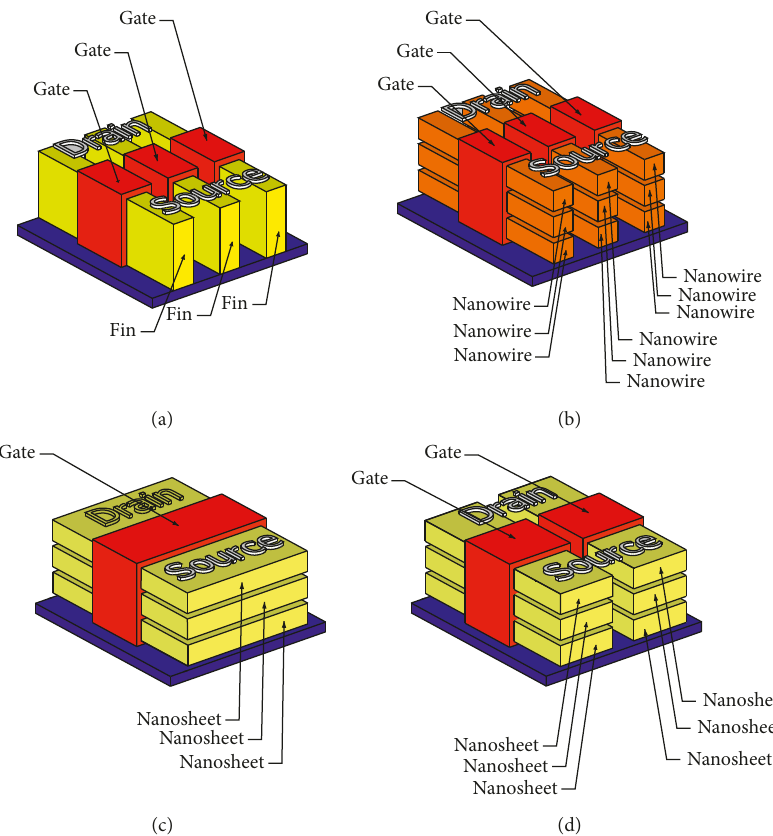
Figure 4: (a) State-of-the-art FinFET, (b) nanowire FET, (c) single-stack nanosheet FET, and (d) double stack nanosheet